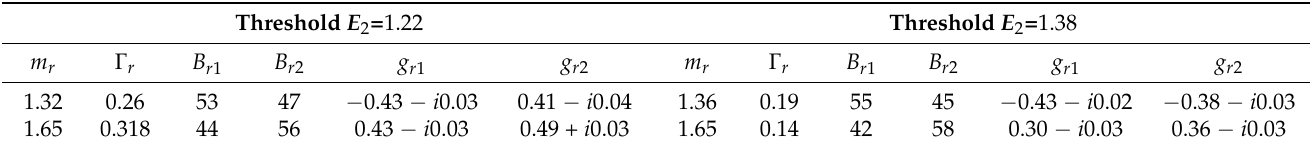
Table 1. BW parameters for two threshold